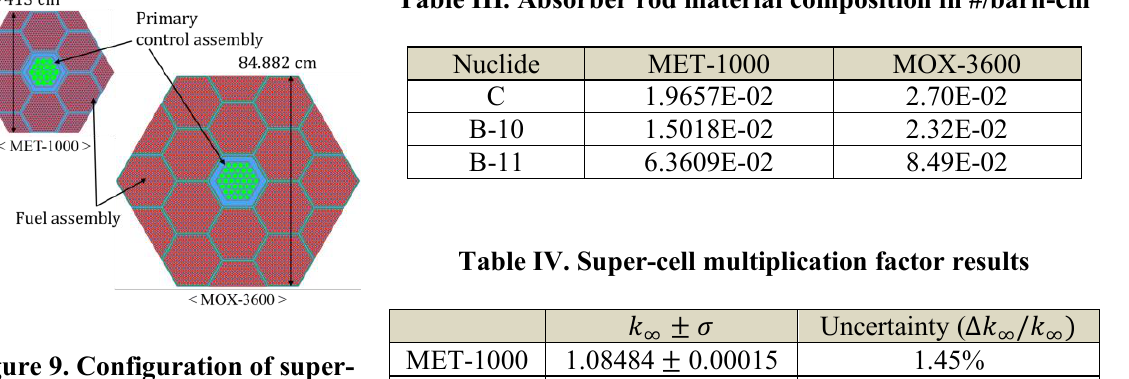
uncertainty 𝒔𝒄𝒂𝒕𝒕,𝟐𝒈